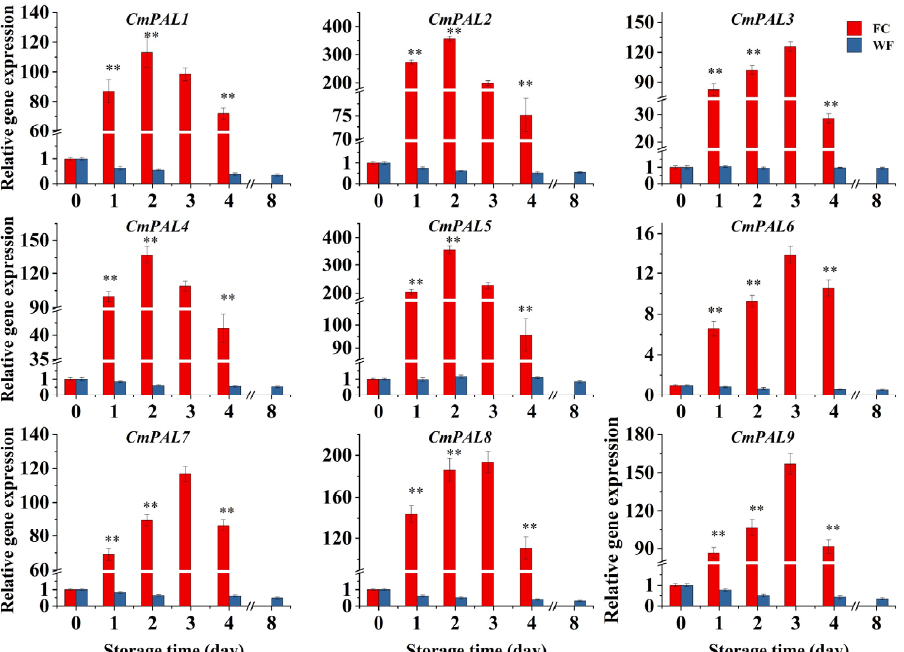
Figure 5. Effect of cutting on the relative gene expressions of phenylalanine ammonia lyase ( CmPALs ) in melon fruit during storage (15 °C). FC and WF respectively represent fresh-cut and whole melon fruit. The values are expressed as means ± SE of three replicates. ** indicate statistically significant differences ( p < 0.01) according to Student’s t -test at each sampling point.